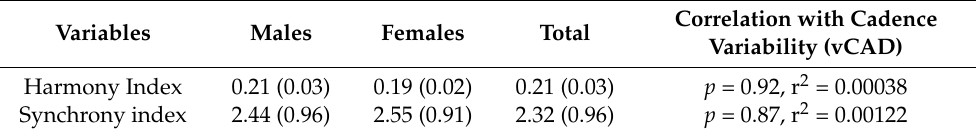
Table 3. Values of harmony indexes derived from the video analysis method are reported for the entire group (Total) and in sex subgroups (Males, Females). In the last column on the right, the results of the correlation analysis with cadence variability, as measured with Optogait, are reported. Correlation with Cadence Variables Males Females Total Variability (vCAD) Harmony Index 0.21 (0.03) 0.19 (0.02) 0.21 (0.03) p = 0.92, r 2 = 0.00038 Synchrony index 2.44 (0.96) 2.55 (0.91) 2.32